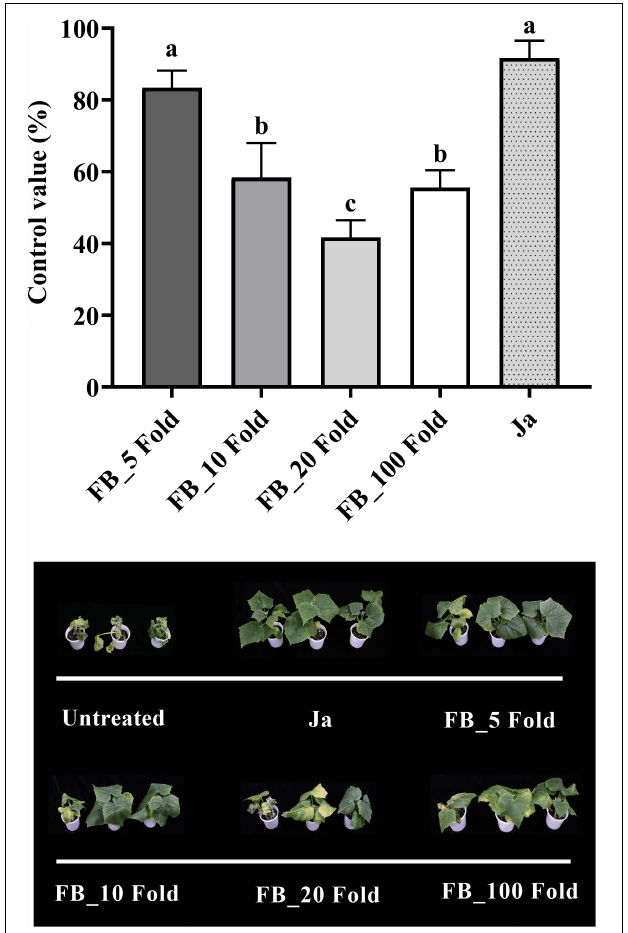
FIGURE 5 | Control efficacy of the fermentation broth of Streptomyces sp. JCK-6131 against cucumber Fusarium wilt in a pot experiment. FB = fermentation broth of Streptomyces sp. JCK-6131, Ja = janroken ( × 1000). Values are presented as the mean ± standard error of three runs, with three replicates each. The bars with the same letters represent non-significant differences between the treatments ( p < 0.05, Fisher’s least significant difference test).